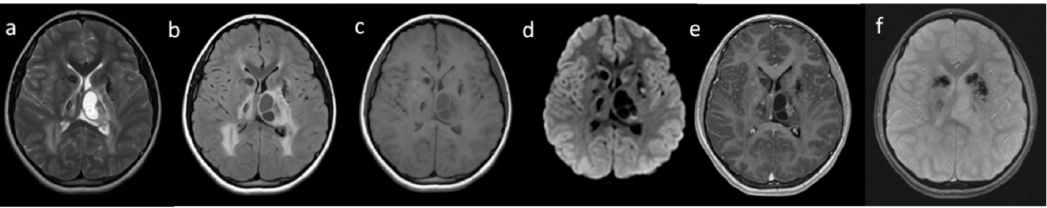
Figure 3. Third brain MRI two years after the first imaging, axial plane: ( a ) T2; ( b ) Flair T2; ( c ) T1; ( d ) DWI; ( e ) T1 + CE; ( f ) SWI (used for the assessment of blood metabolites and calcifications) sequences; white matter hyperintensity progression, cyst enlargement with the mass effect and calcification artifacts.